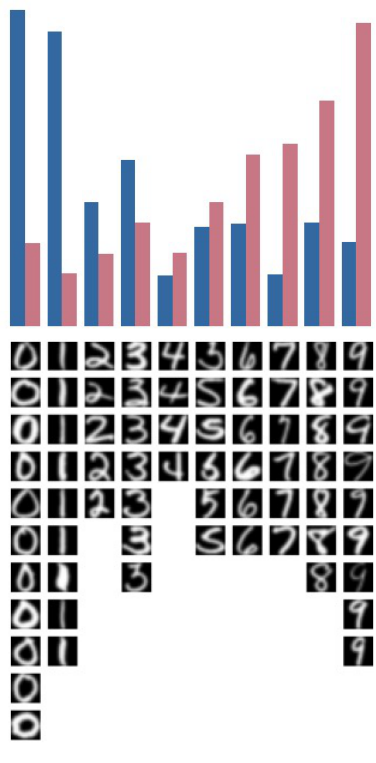
Figure 15. Dependent MMD coreset for two datasets of handwritten digits. Bars show the weight in each marginal coreset, with X a shown in blue and X b shown in red ; images along axis show corresponding exemplars.